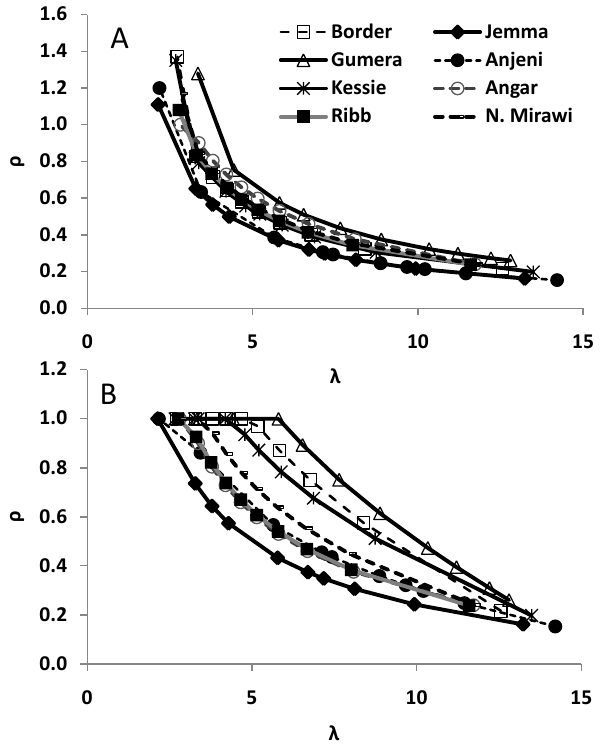
Fig. 3. Distribution of the effective depth coefficient ( ρ i ) values defined by Eq. (4) (a) and Eq. (8) (b) for the various sub-basins.